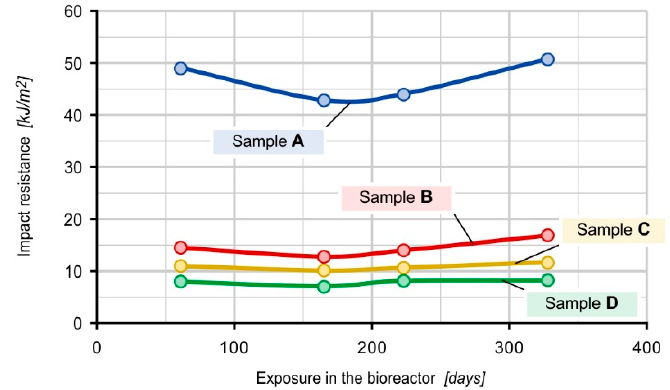
Figure 7. Impact bending test results.